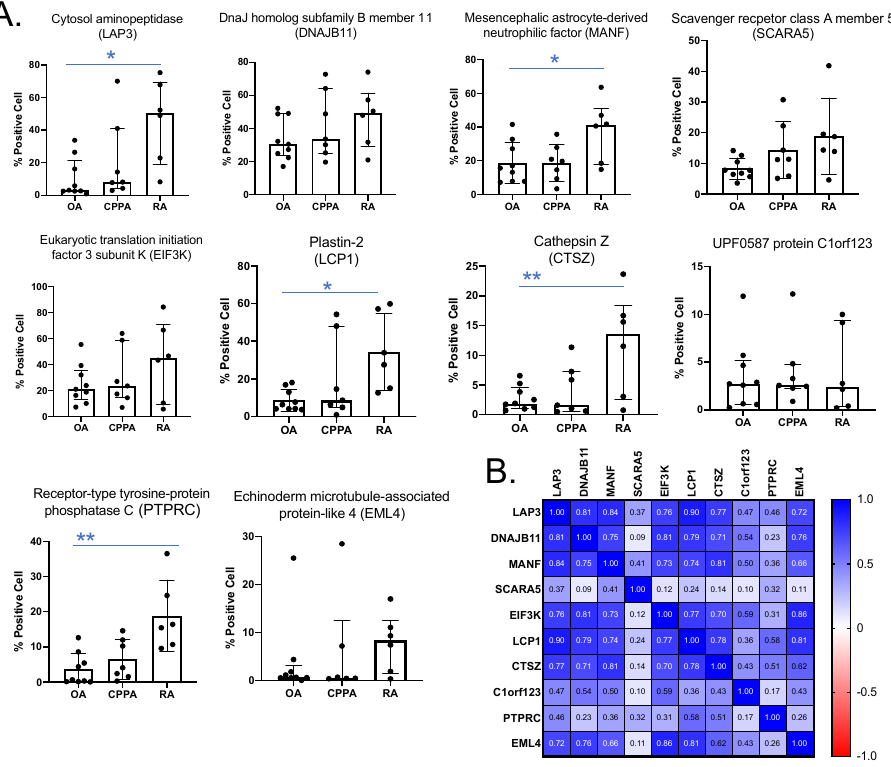
Figure 2. Immunohistochemistry (IHC) quantification of the 10 highlighted proteins in synovial membrane from OA, CPPA and RA patients. ( A ) Representation of protein quantification (optical density values) obtained by QuPath after IHC. One-way ANOVA test (post hoc of Tukey) or Kruskal– Wallis test (post hoc test of Dunn’s) was applied depending on normal distribution: * P < 0.05 and ** P < 0.01 ( B ) Correlation coefficients between the 10 highlighted biomarkers calculated according to the non-parametric Spearman test. OA, osteoarthritis; CPPA, chronic pyrophosphate arthropathy; RA, rheumatoid arthritis.